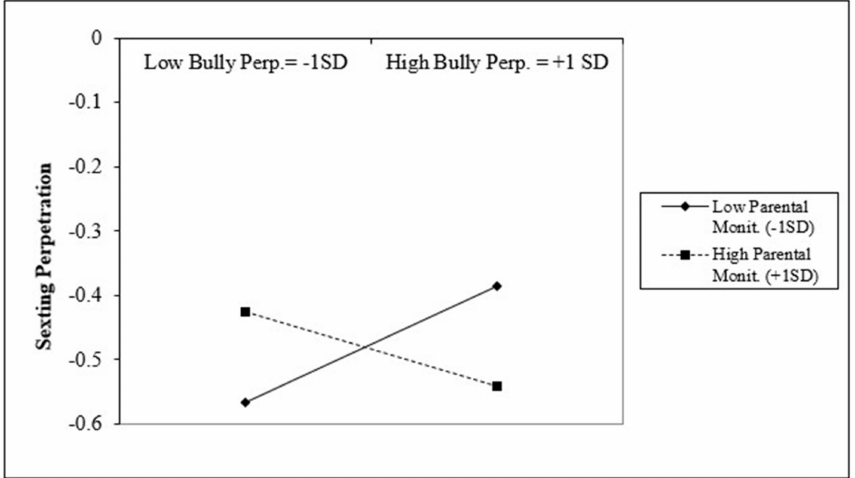
Figure 2. Interaction between bullying perpetration and parental monitoring for LGB